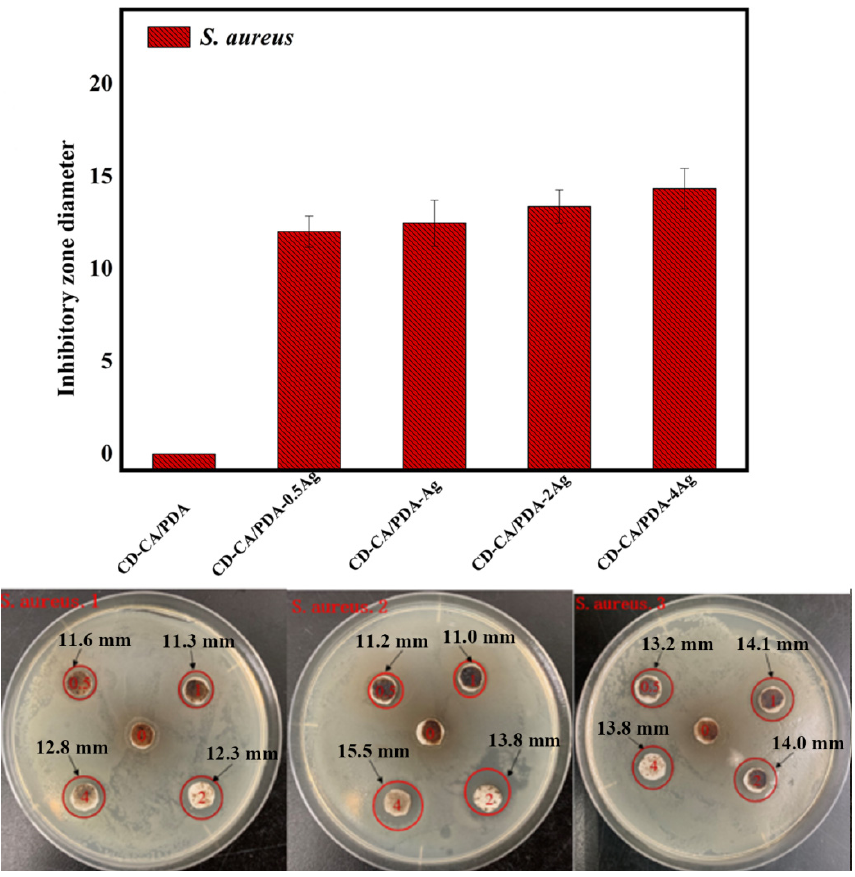
Figure 9. Diffusion inhibition zone of CD-CA/PDA and CD-CA/PDA-xAg to S. aureus .